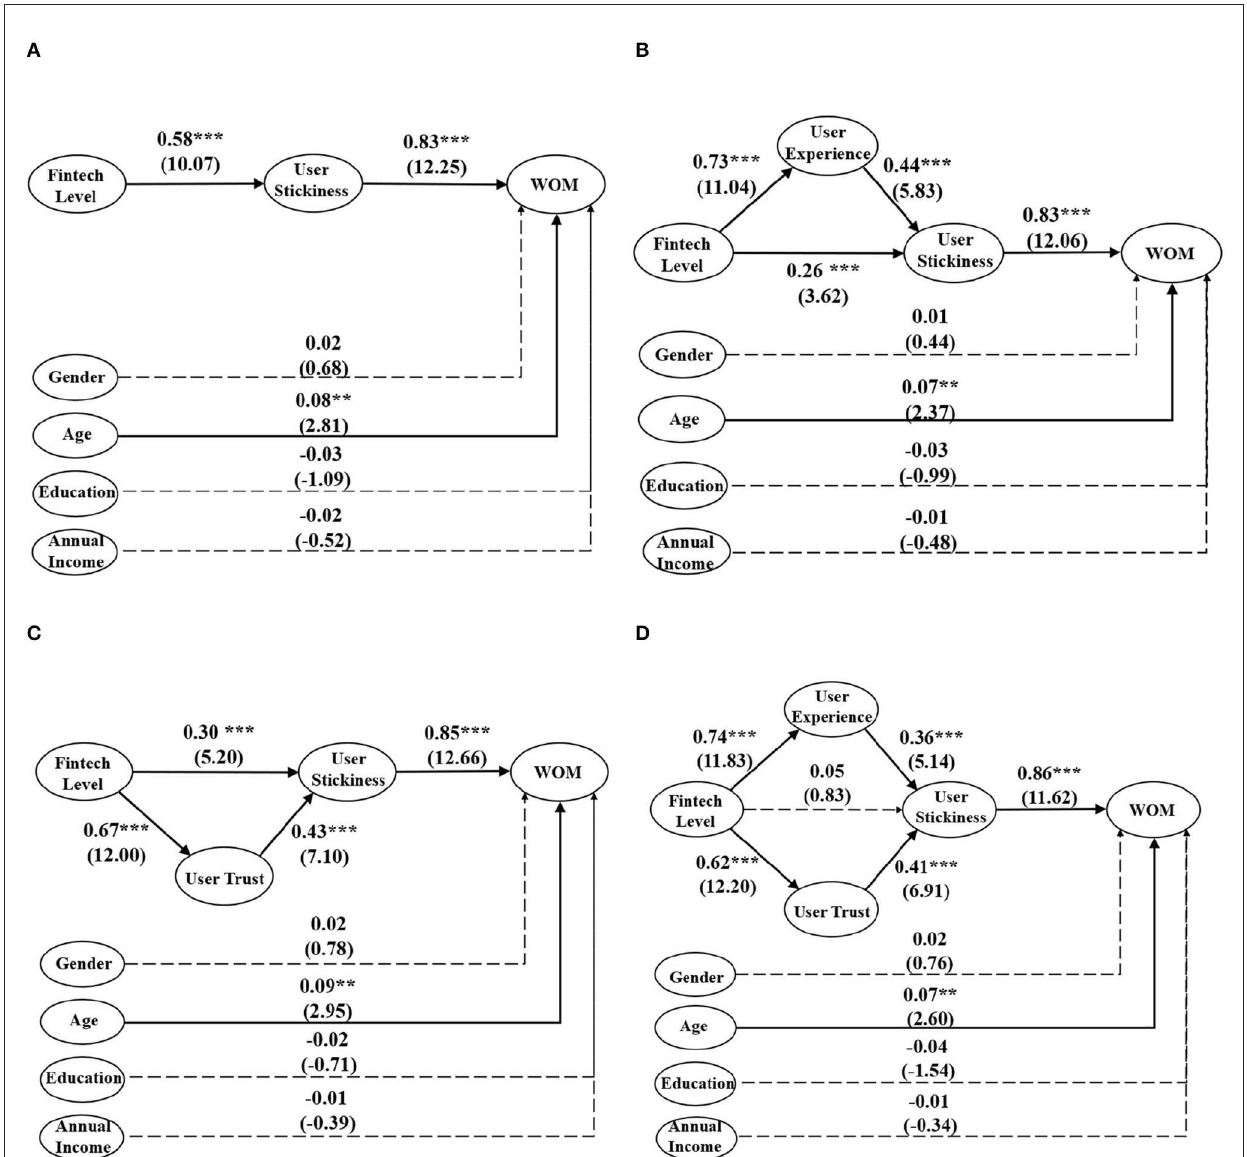
FIGURE3 Test of mediation effect between fintech level and user stickiness (Solid arrows mean significant, dashed arrows mean insignificant; *** significant at 0.001 level; ** significant at 0.01 level). (A) No mediation effects (from fintech level to user experience). (B) User experience as the mediation. (C) User trust as the mediation. (D) Two mediation added (user experience and user